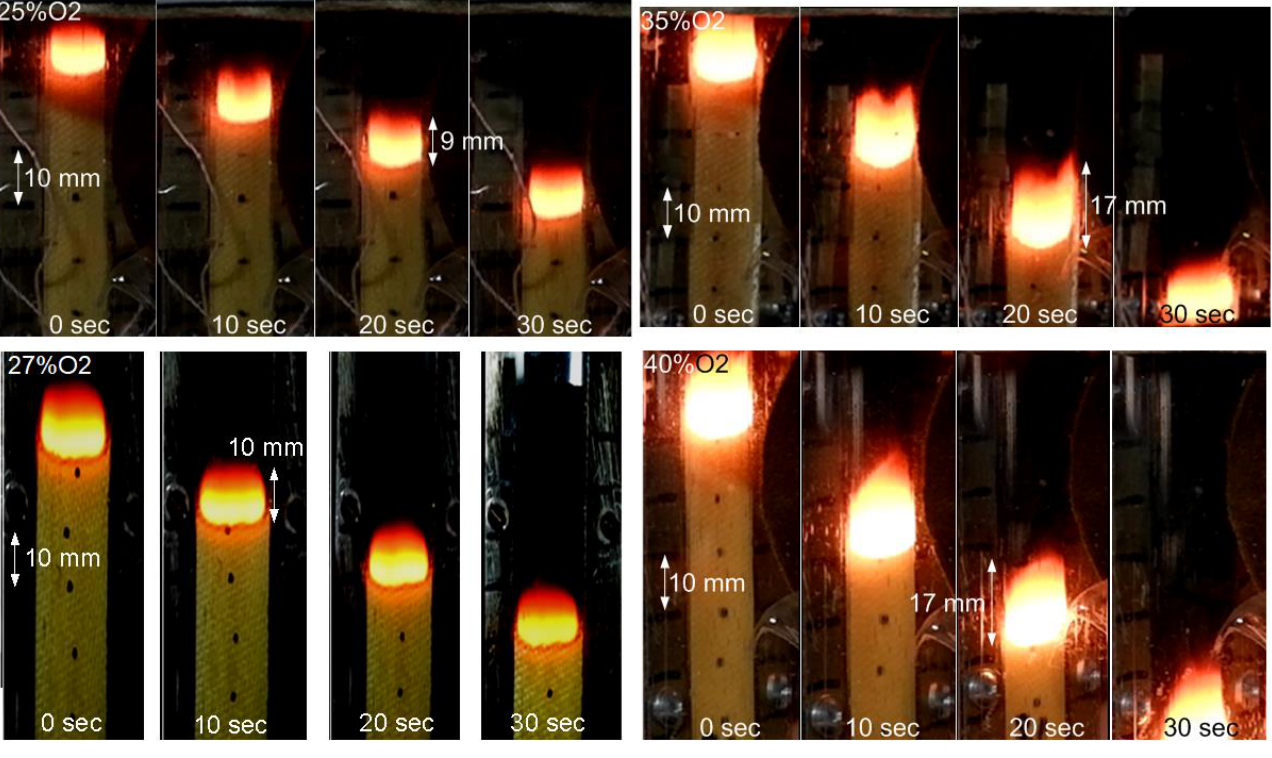
Figure 4. Photos of flame propagation over 0.3 mm-thick GFRER slabs at oxygen concentrations varying from 25% to 40%.